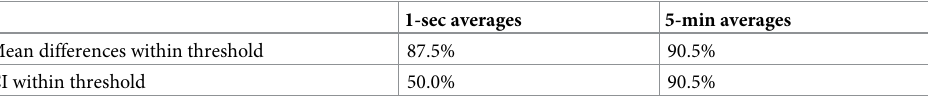
Table 2. Percentage of patients who met the threshold of 5 bpm for both the mean differences as well as CI for 1-sec averages and 5-min